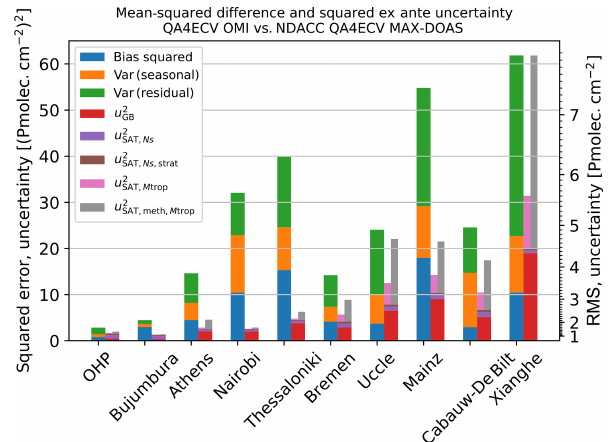
Figure 12. Two stacked bar plots are provided for each site. The left bar shows the mean-squared difference of QA4ECV OMI NO 2 vs. QA4ECV MAX-DOAS, which is split into three components: (i) the square of the mean difference, (ii) the variance of the rolling monthly mean difference and (iii) the variance of the residual dif- ference. The right bar shows the combined ex ante uncertainty of QA4ECV OMI NO 2 –QA4ECV MAX-DOAS, which is split into four components: (i) the MAX-DOAS squared uncertainty, (ii) the QA4ECV OMI squared uncertainty contribution from the total SCD and (iii) from the stratospheric SCD, and (iv) the QA4ECV OMI squared uncertainty contribution from the tropospheric AMF. Also shown is the AMF component of the methodological uncertainty, derived by intercomparing the retrieval methodologies by Lorente et al. (2017), which is referred to as structural uncertainty in this work. The right y axis provides a square-root scaling of the corre- sponding